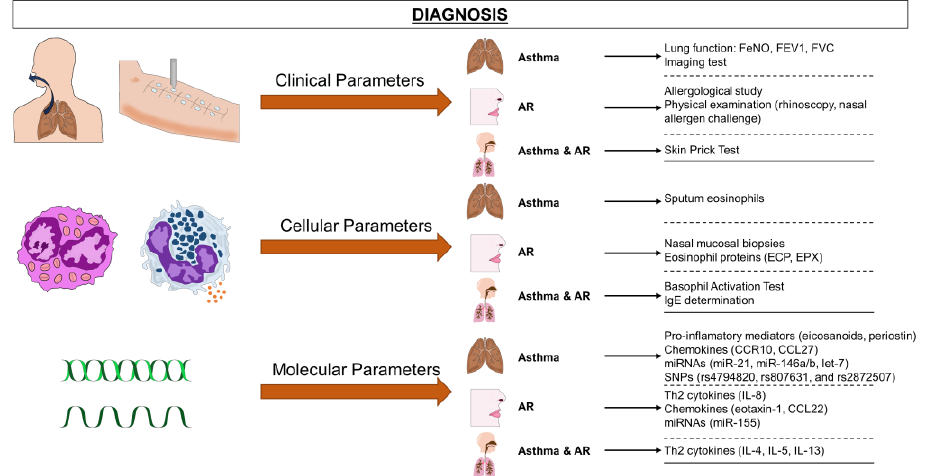
Figure 2. Diagnostic tools in asthma and AR. Different diagnostic methods can be used in asthma diagnosis, from classical methods (lung function, medical history, skin prick test) to cellular (eosinophil counts, basophil activation test) and molecular (measurements of cytokines and chemokines, and other biomarkers such as miRNAs) novel methods.